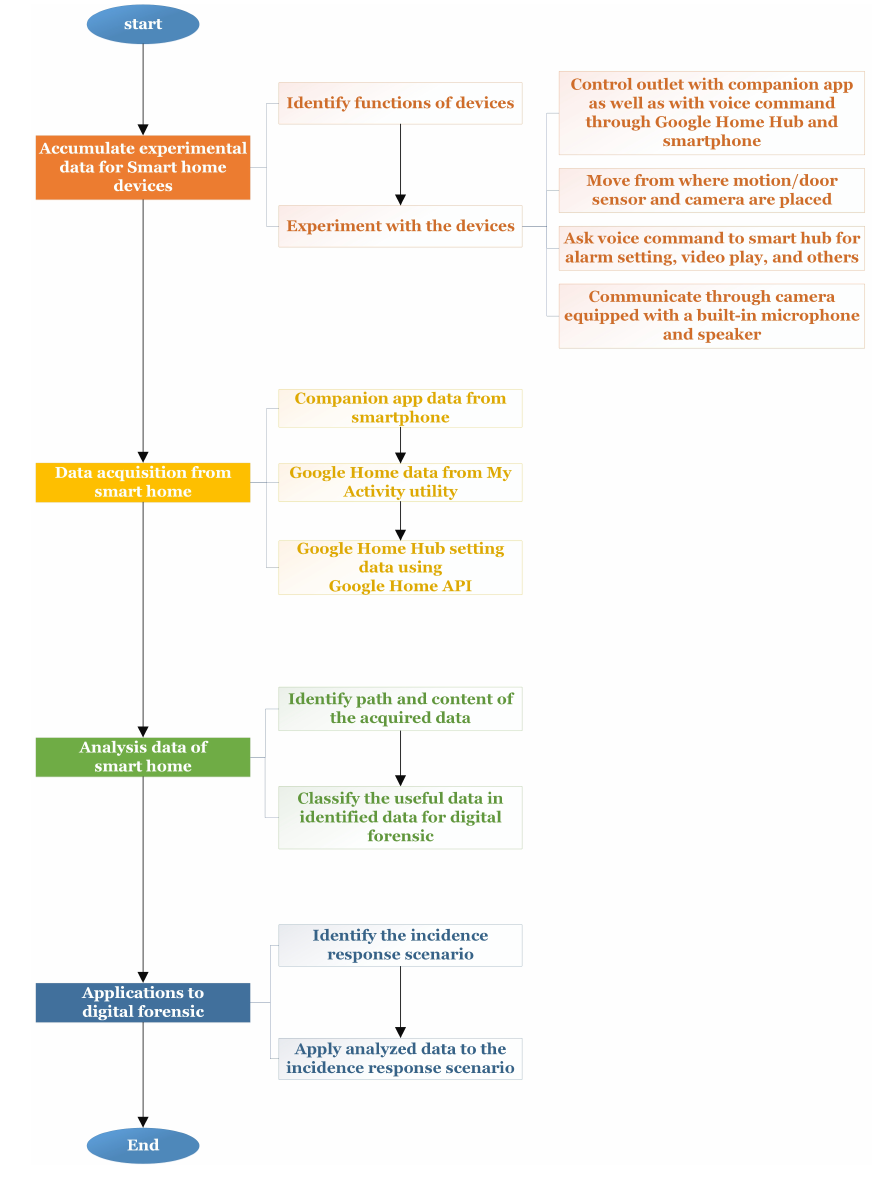
Figure 1. Workflow of the smart home forensic